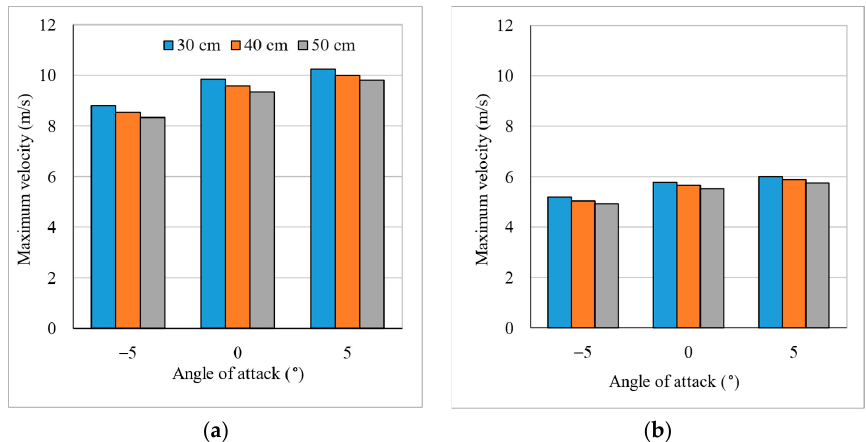
Figure 13. Maximum velocities at different gaps and angles of attacks. ( a ) U ∞ = 5 m/s ( b ) U ∞ = 3 m/s.